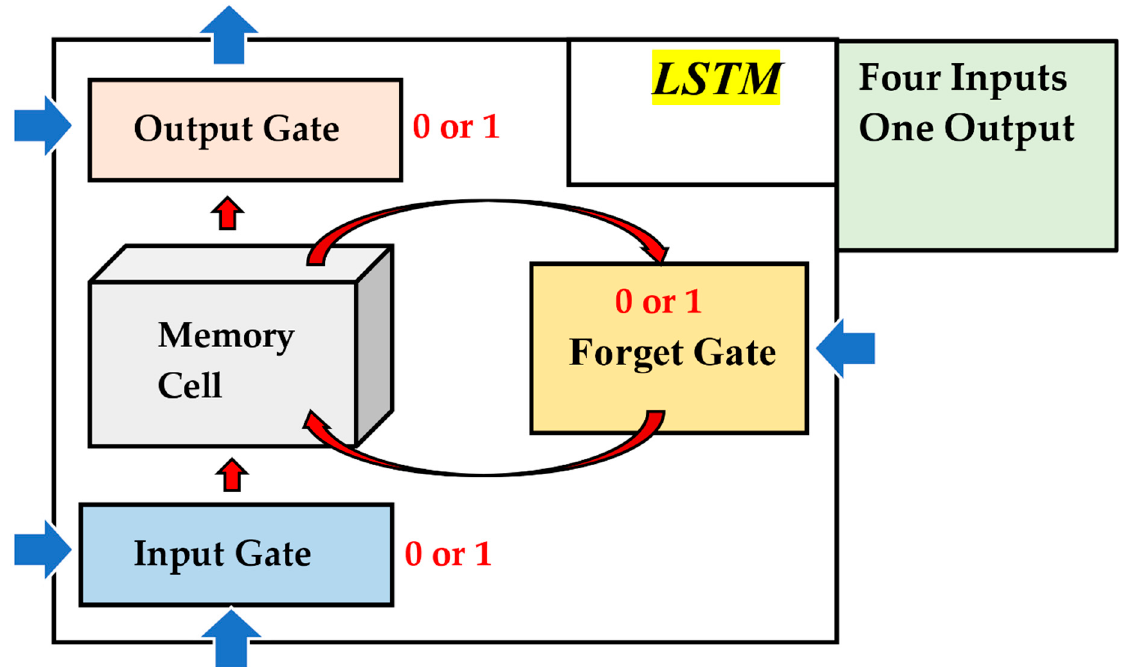
Figure 6. The three gates of one LSTM layer.